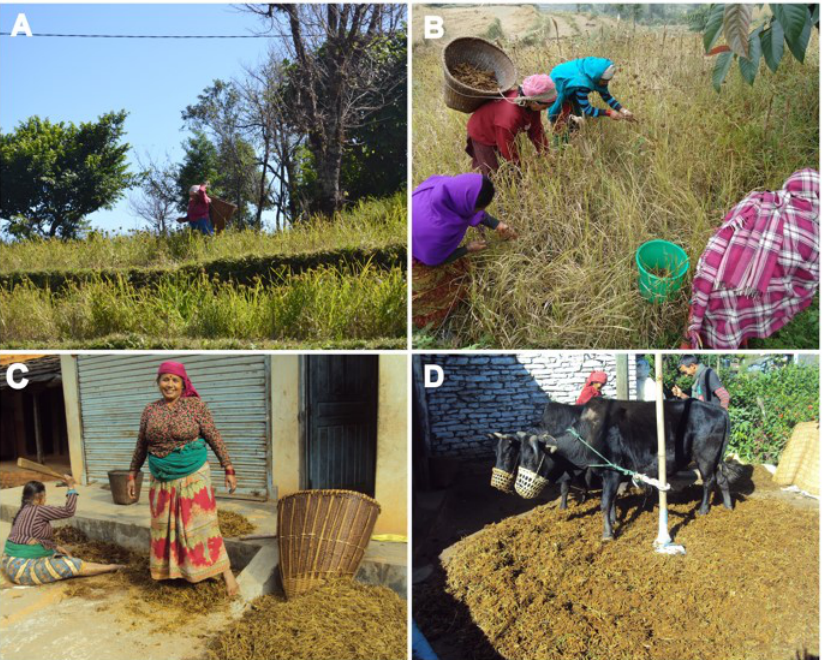
Figure 2. Manual labour associated with finger millet production. ( A , B ) Harvesting of finger millet by women in a terraced field of a smallholder farmer in Nepal; ( C ) Hand threshing of finger millet with a wooden pole by women in Nepal; ( D ) Threshing of finger millet with oxen in Nepal. Picture sources: LI-BIRD photo